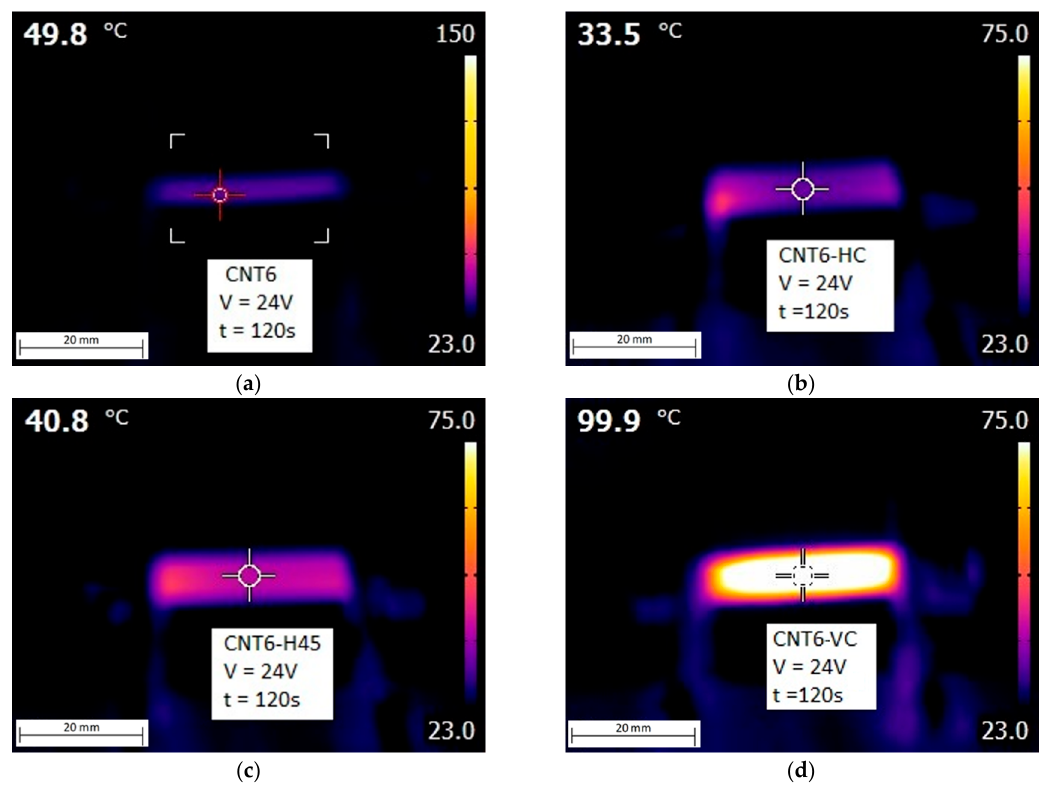
Figure 15. Results of thermal imaging upon voltage application at 24 V at 120 s: CNT6 filament ( a ); CNT6-HC ( b ); CNT6-H45 ( c ) and CNT6-VC ( d ).